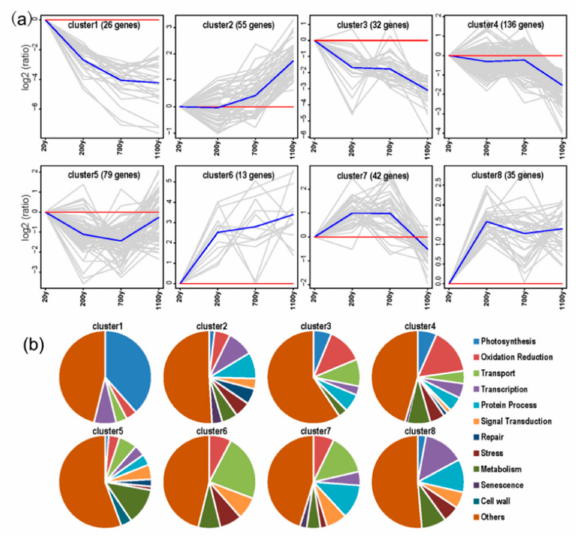
Figure 7. K-means clustering of gene expression profiles. ( a ) The centers of eight clusters with di ff erent expression patterns. The number of genes in each cluster is indicated; ( b ) Functional classification of each